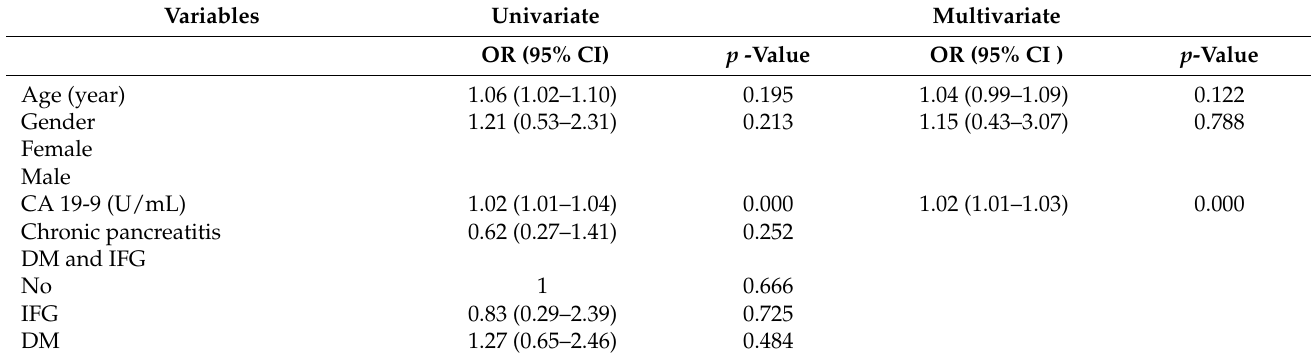
Table 3. Risk factors associated with